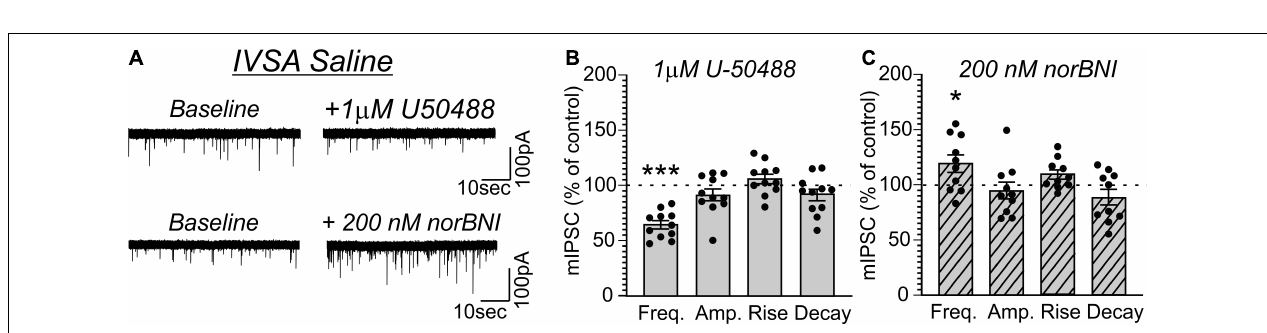
FIGURE 6 | (A) Representative mIPSCs from CeA neurons during control and during superfusion with the KOR-agonist U-50488 (1 µ M, upper panel) or the KOR-antagonist norBNI (200 nM, lower panel) are shown. Bars represent means ± S.E.M of the normalized effects either (B) U-50488 or (C) norBNI at the indicated concentration on mIPSC characteristics. Statistically significant differences to baseline control were calculated using a one-sample t -test. (*) = P < 0.05, (***) = P < 0.001.